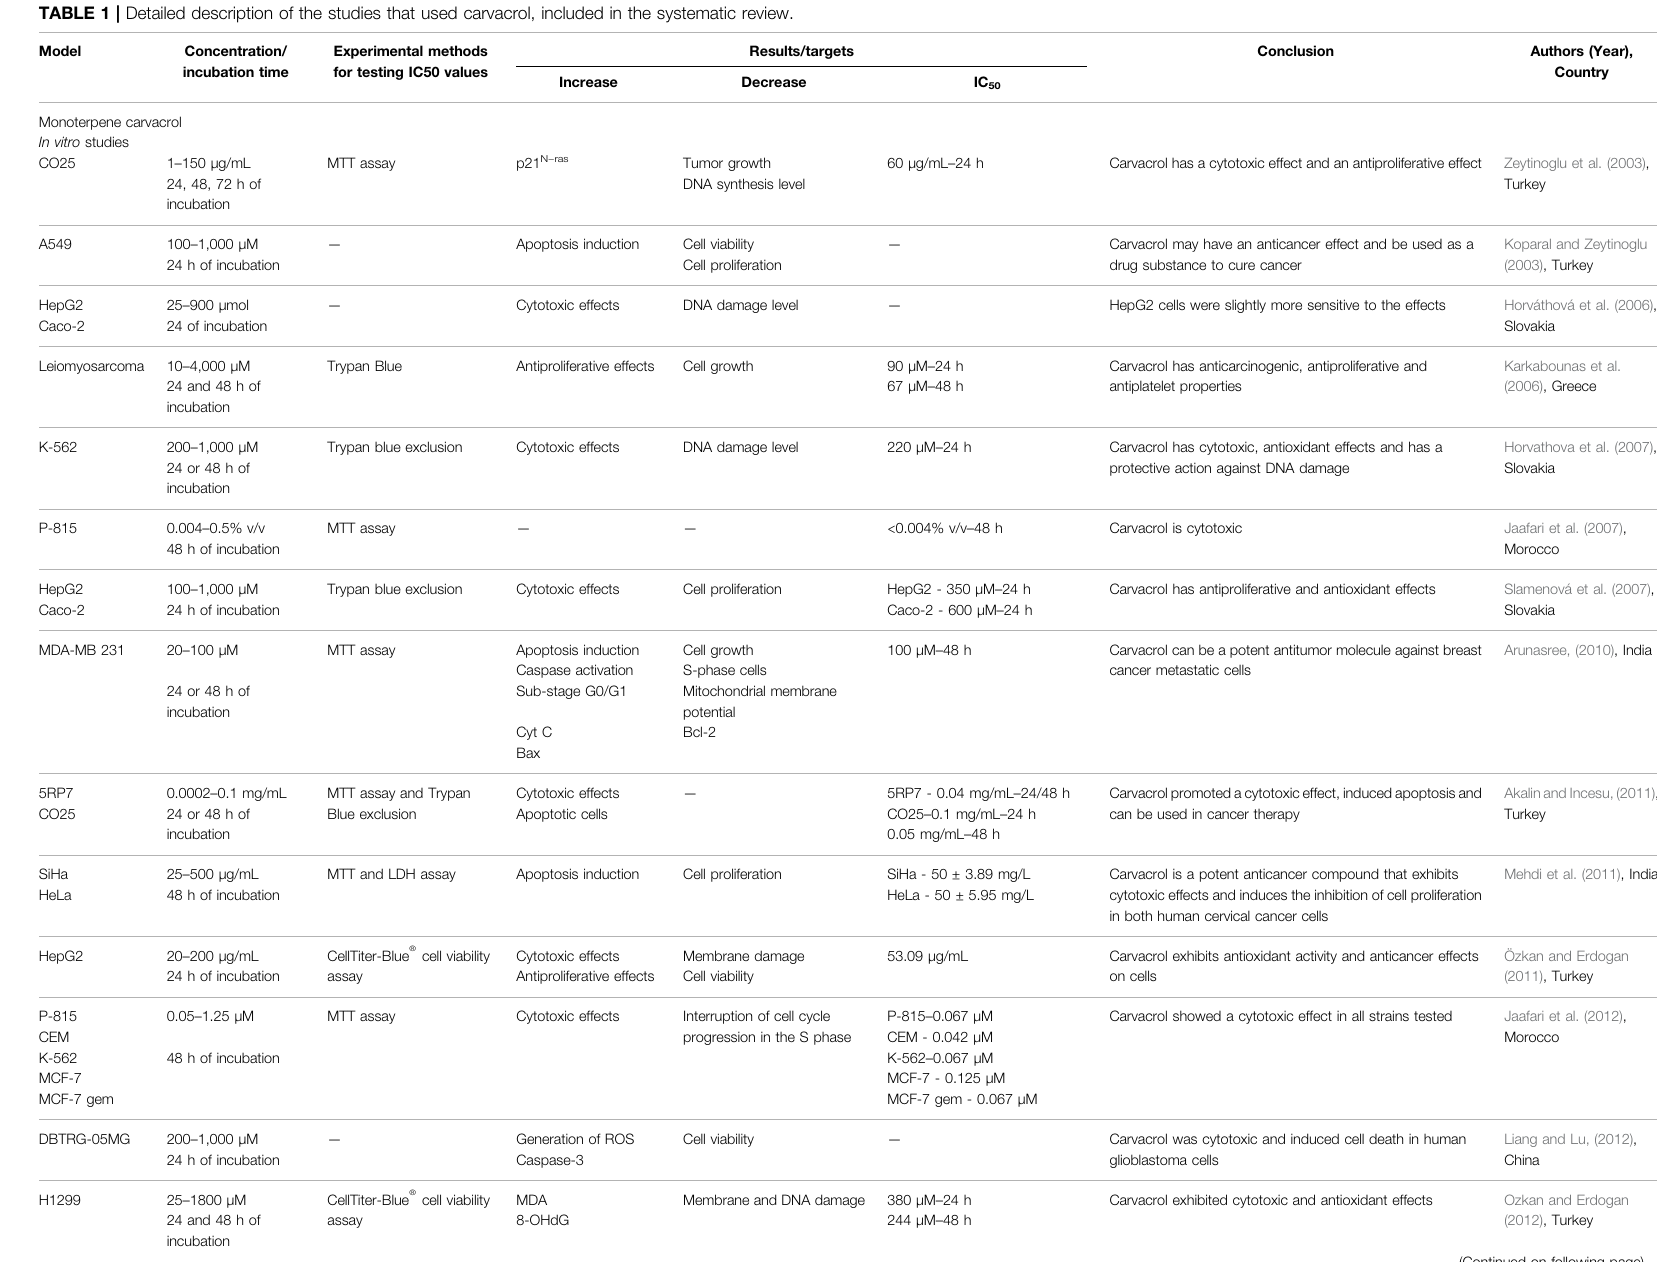
TABLE 1 | Detailed description of the studies that used carvacrol, included in the systematic